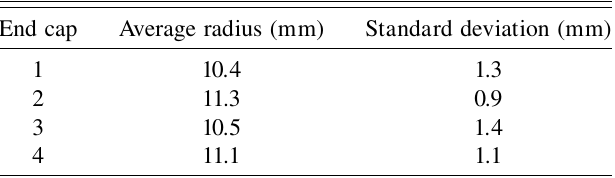
TABLE VIII. Average radius and standard deviation of crack positions for each end cap.